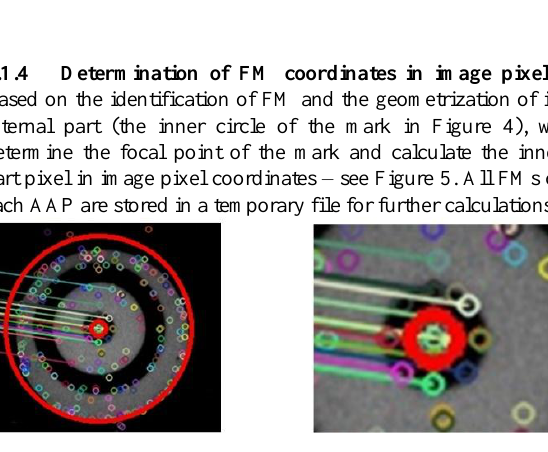
Figure 5. Geometrisation of inner part of an FM (left);